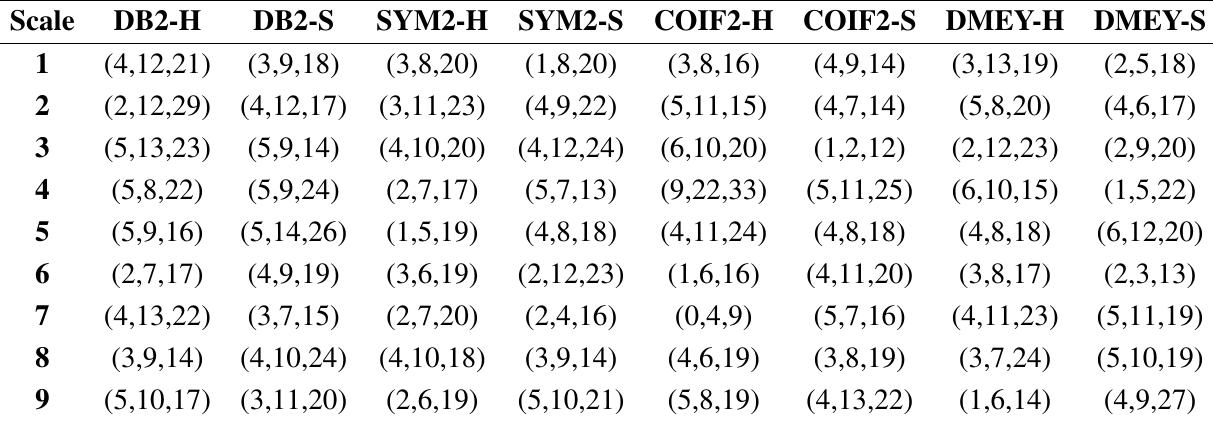
Table 2. Exceedances for different model